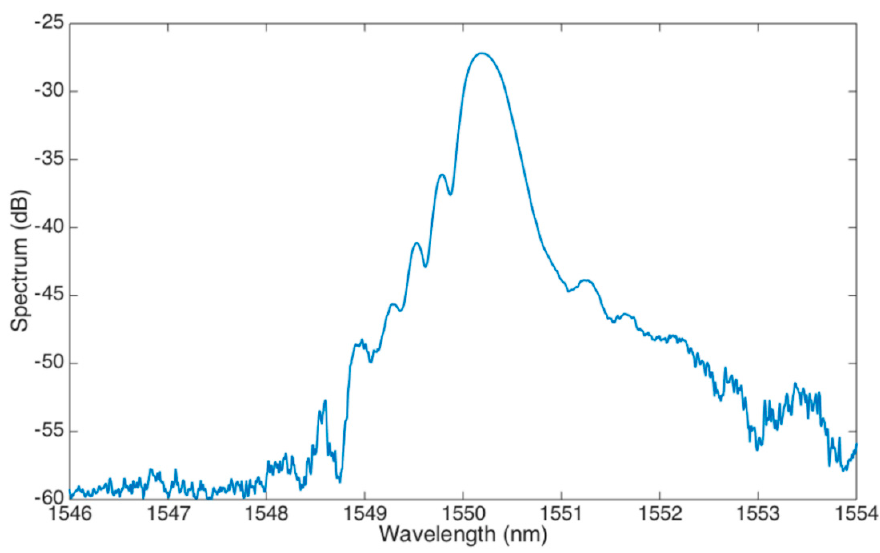
Figure 4. FBG spectrum before etching.